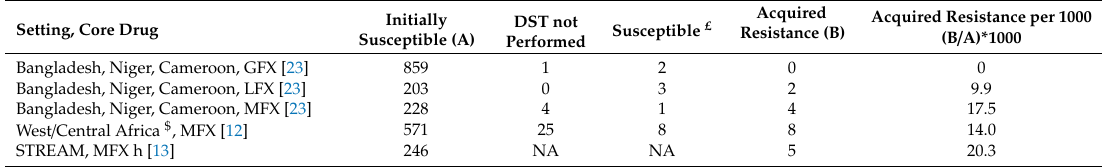
Table 5. Acquired resistance to fluoroquinolone among initially susceptible cases #